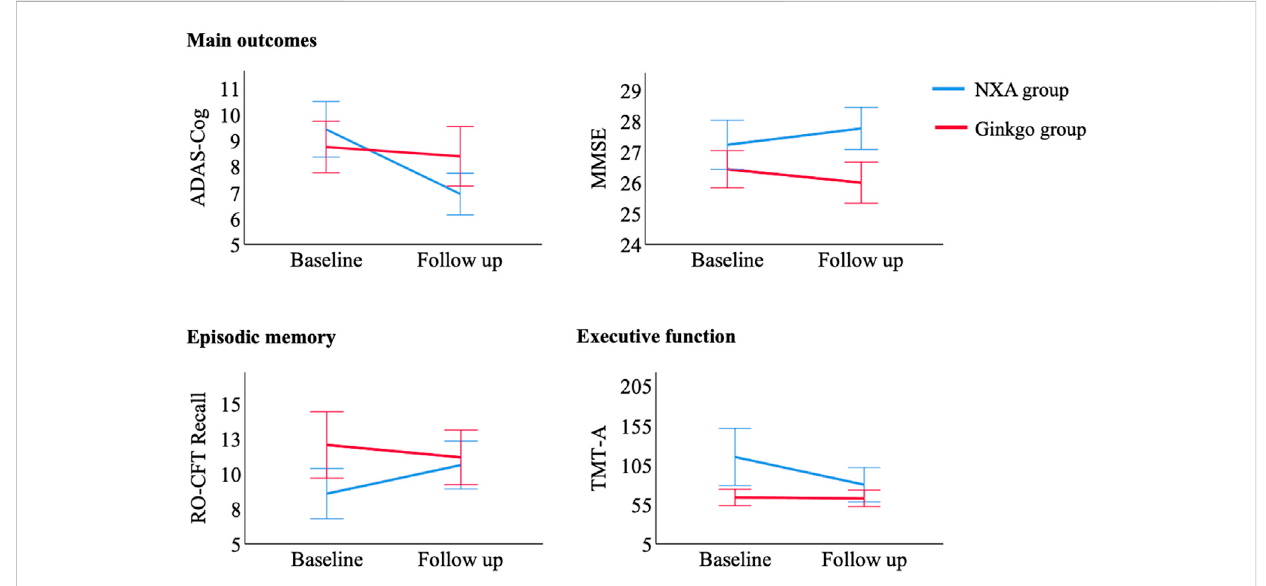
FIGURE 1 Controlofcognitivetestswithsigni fi cantpre-andpost-treatmentinteractionbetweentheNXAgroupandginkgogroup.Abbreviation:ADAS-cog= Alzheimer ’ s Disease Assessment Scale-Cognitive subscale; MMSE = Mini-Mental Status Examination; RO-CFT = Rey-Osterrieth Complex Figure test; TMT = Trail Making